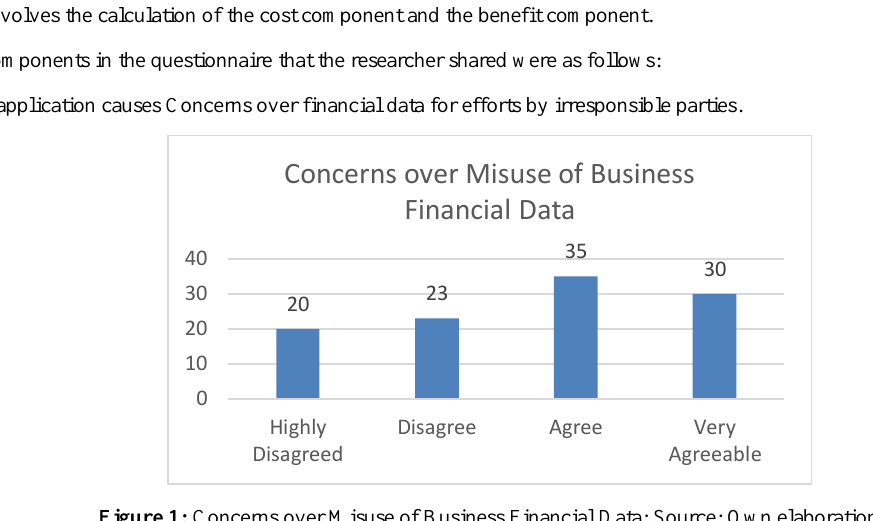
Figure 1: Concerns over Misuse of Business Financial Data; Source: Own elaboration.